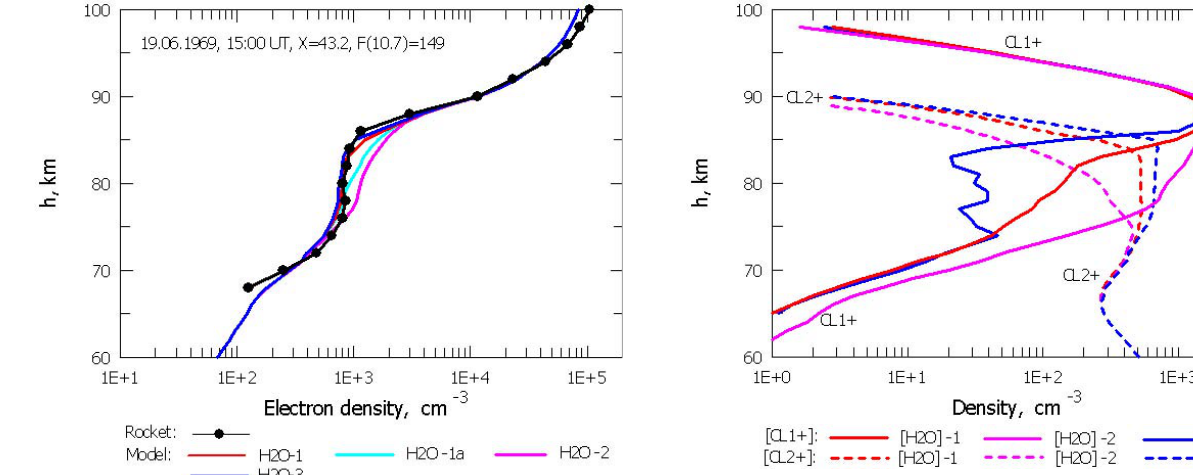
Fig. 7a. Electron density profiles for 19 June 1969 at 15:00UT, with χ = 43 . 2 ◦ and F 10 . 7 = 149, as measured by the rocket (black dotted line) and calculated for H 2 O-1, H 2 O-1a, H 2 O-2 and H 2 O-3 profiles presented in Fig. 2.